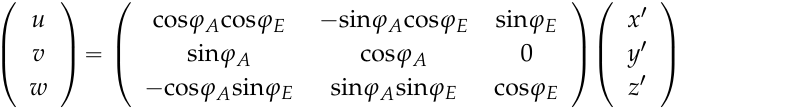
Figure 2. The three-dimensional imaging model of rotating target.